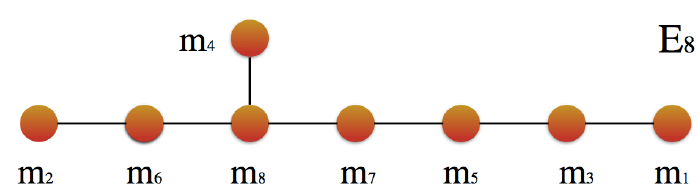
Figure 2: E Dynkin diagram as a representation of the mass spectrum of the 8